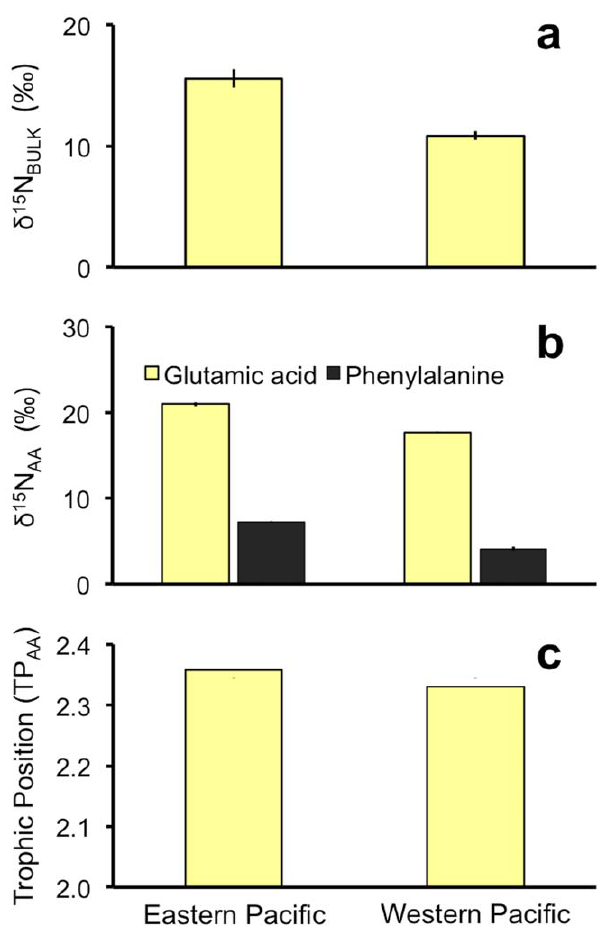
Figure 3. Leatherback turtle skin nitrogen stable isotopic compositions. a , nitrogen isotopic composition of skin from leatherback turtles known to feed in the eastern and western Pacific; b , nitrogen isotopic composition of glutamic acid and phenylalanine in skin tissue from leatherback turtles feeding in the eastern and western Pacific; c , trophic position calculated using the isotopic compositions of glutamic acid and phenylalanine [17], presented as a weighted average based on AA measurement error. Error bars represent weighted standard deviation of trophic position means; n =3 each. While there was a significant difference in skin d 15 N between eastern and western Pacific foragers (t-test: p , 0001), there was no significant difference in trophic position between these two groups (t-test: p